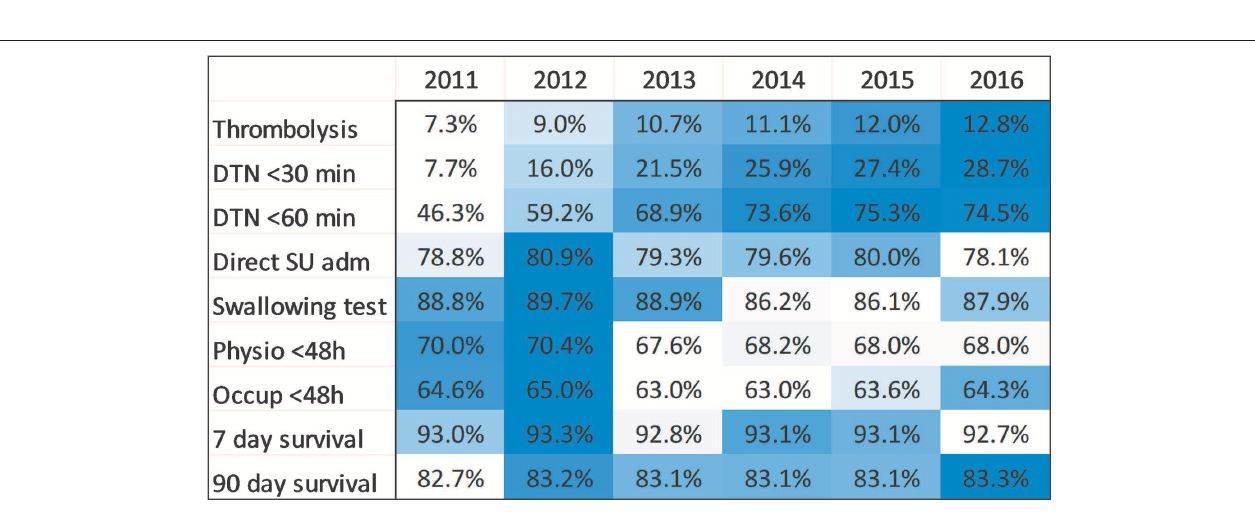
FIGURE 2 | Heatmap with unadjusted analyses of survival and all quality-of-care indicators per year. Darker blue color indicates higher rates.